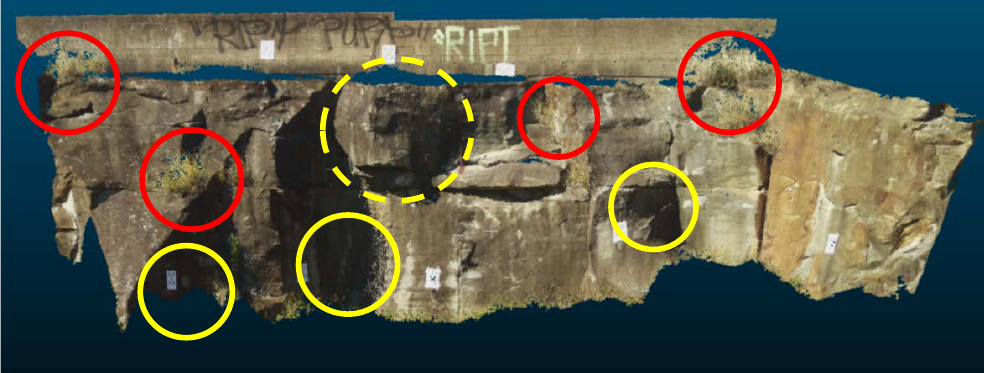
Figure 5. One of the photogrammetric digital models with the areas with vegetation highlighted by red circles and the shadowed areas highlighted by yellow circles: the dashed yellow circle has been further analysed.